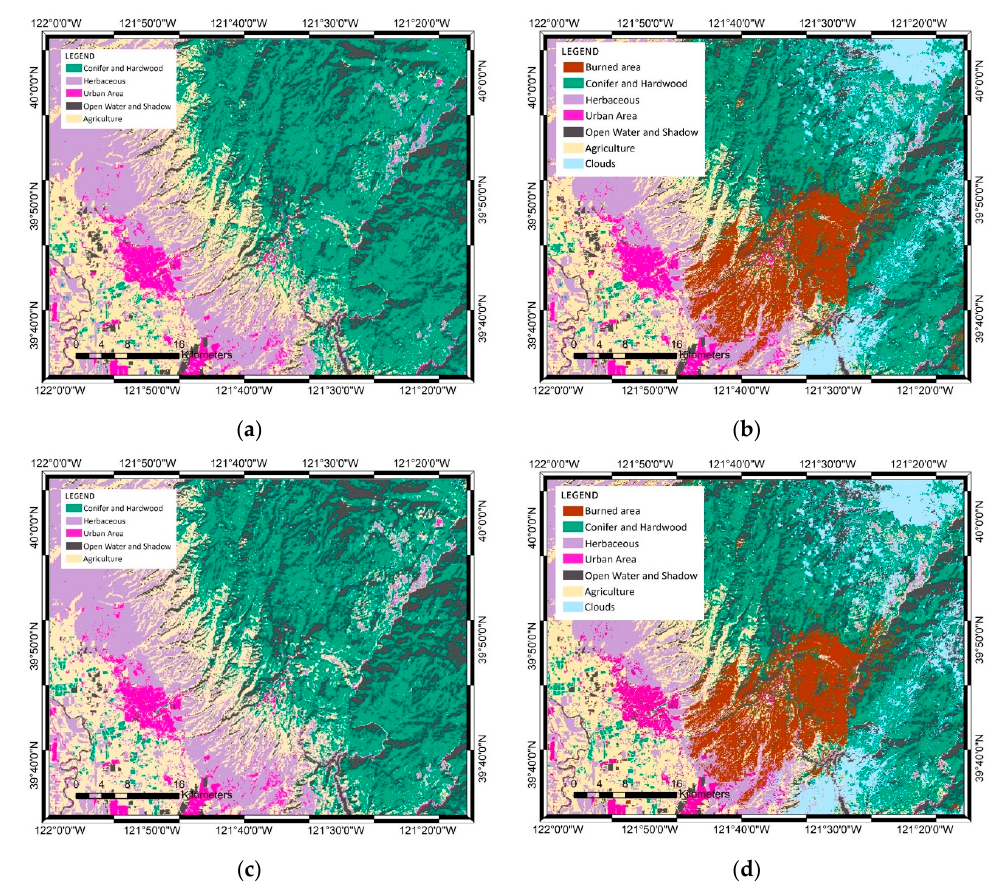
Figure 7. Results of the SVM and SVM–ICA classifications from the Landsat ‐ 8 imagery of the Camp Fire wildfire: ( a ) SVM pre ‐ wildfire map, ( b ) SVM post ‐ wildfire map, ( c ) SVM–ICA pre ‐ wildfire map, Fire wildfire: ( a ) SVM pre-wildfire map, ( b ) SVM post-wildfire map, ( c ) SVM–ICA pre-wildfire map, and ( d ) SVM–ICA post ‐ wildfire map. The pre ‐ and post ‐ wildfire data were acquired on September and ( d ) SVM–ICA post-wildfire map. The pre- and post-wildfire data were acquired on September 21, 21, 2018 and December 26, 2018 respectively. 2018 and December 26, 2018